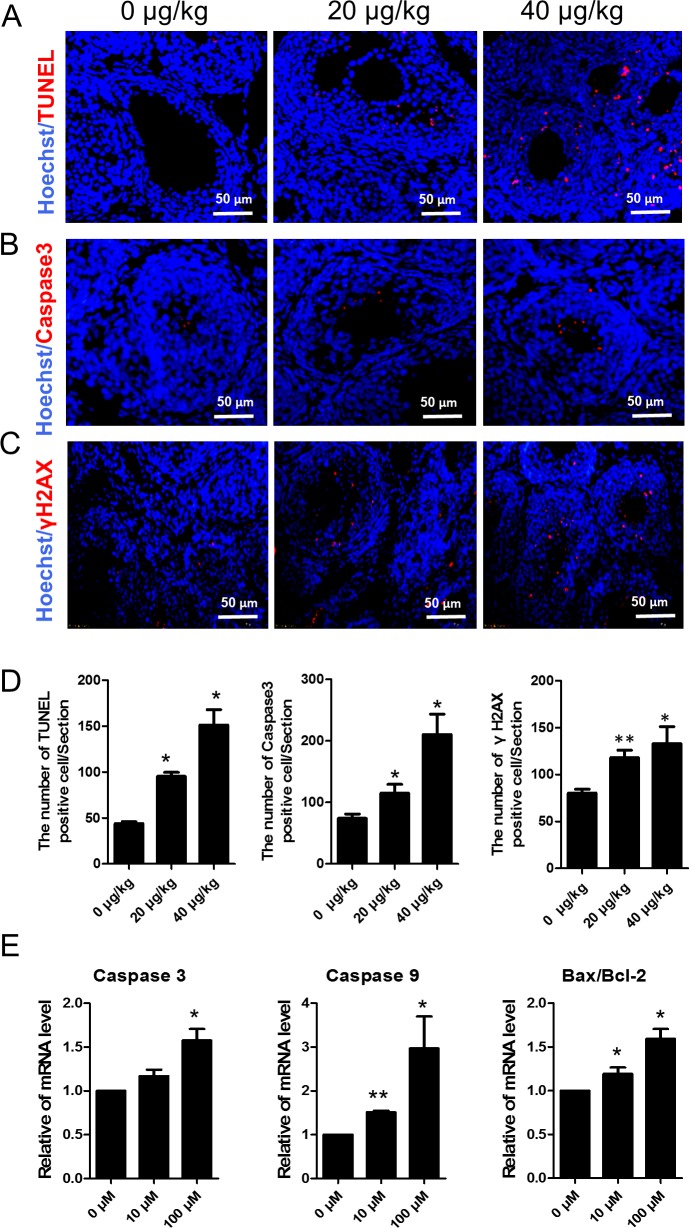
DEHP exposure increases DNA damage and apoptosis of ovarian somatic cells.(A) Apoptosis was examined by the terminal deoxyribonucleotidyl transferase-mediated dUTP-digoxigenin nick end-labelling (TUNEL) assay. The number of apoptotic cells increased significantly after treatment with DEHP when compared with the control group. (B) Apoptosis related proteins Caspase3 immunofluorescence. (C) DNA damage related proteins γH2AX immunofluorescence. Cell nucleuses are stained blue with Hoechst33342. (D) The numbers of TUNEL, Caspase3 and γH2AX positive cells per section. (E) The change of mRNA levels of related apoptosis genes Caspase3, Caspase9, and Bax/Bcl-2 in the control and DEHP-treatment groups in in vitro experiments. Compared to the control group, relative fold changes were presented as mean ± SD. All experiments were repeated at least three times independently. (* P < 0.05; ** P < 0.01).